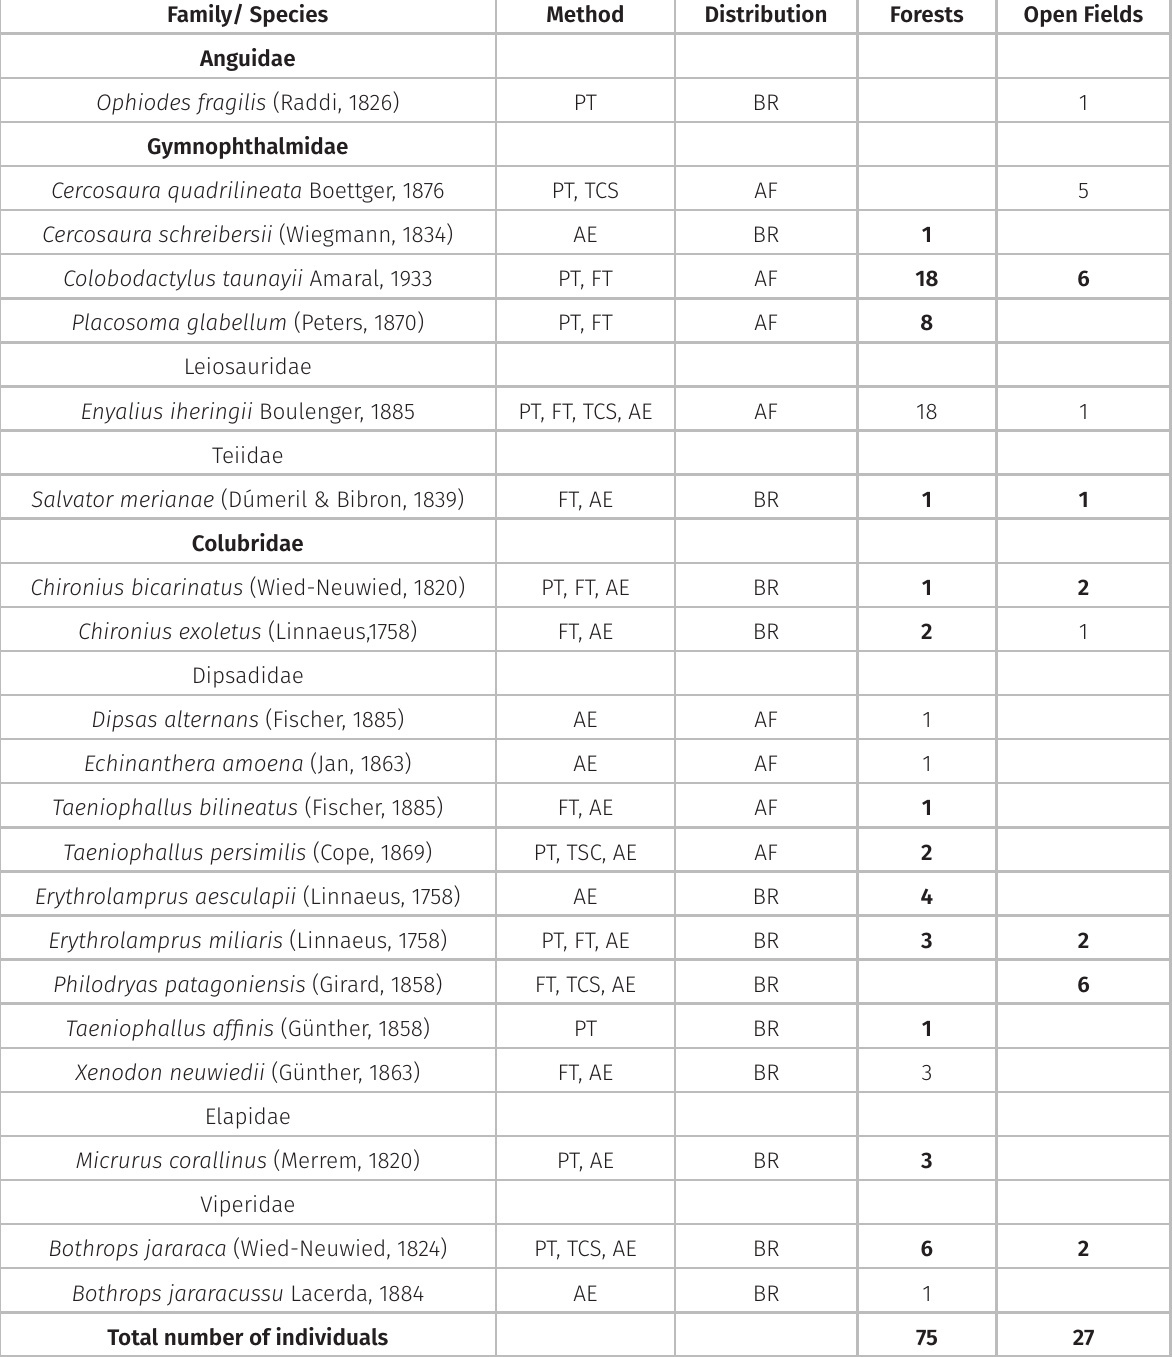
Table I. Squamate reptile composition of Curucutu nucleus, sampling method, distribution (according to Guedes et al. 2018), and abundance in forest and open fields individuals collected in sampling units and used Mantel test they are bold; see details on text. Method: PT: Pitfalls traps with drift fences, FT: Funnel traps, TCS: Time- constrained searches, AE: accidental encounters. Geographic distribution: AF: species restricted to the Atlantic Forest (southeastern, northeastern and/or southern Brazil), BR: species broadly distributed in Brazil, with records outside of the Atlantic Forest